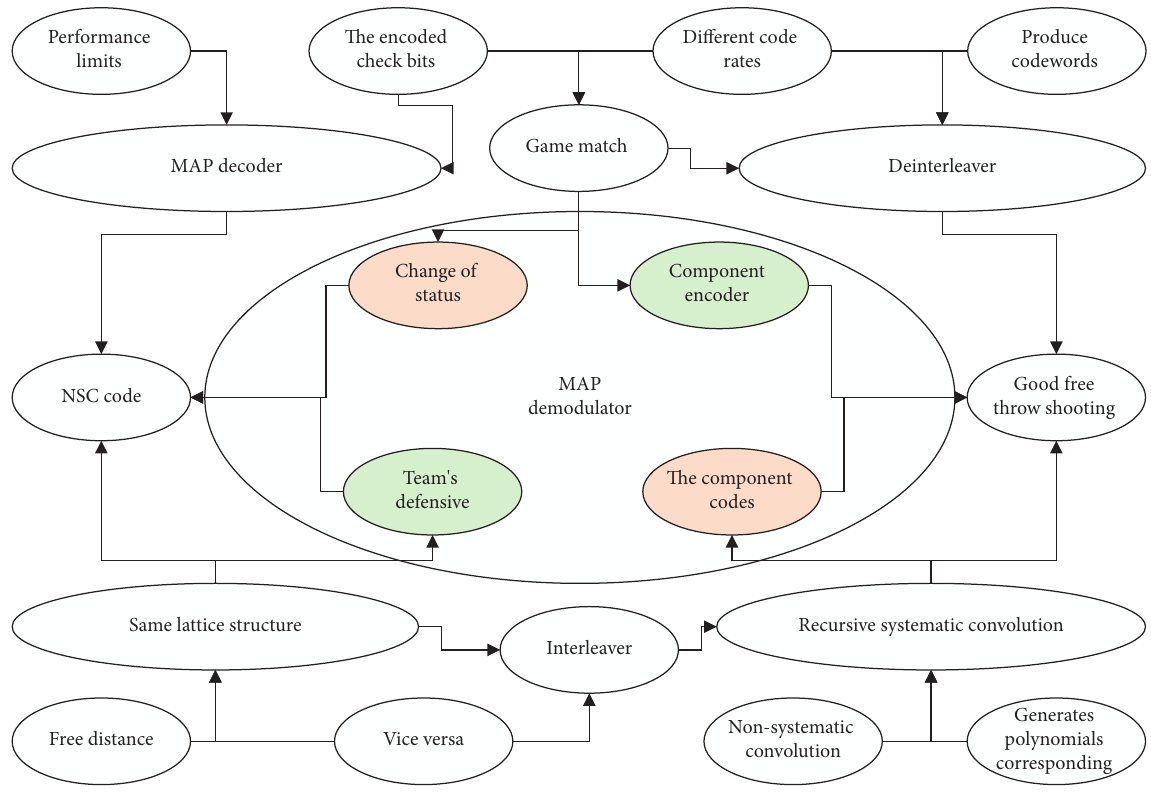
Figure 6: Turbo receiver architecture for ISI channel.